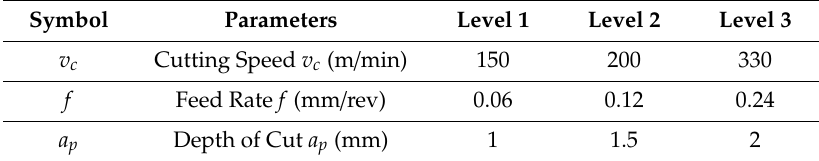
Table 3. Cutting parameters and factor